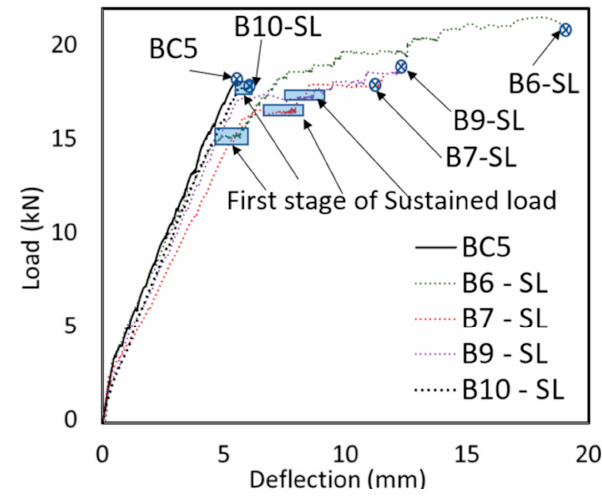
Figure 10. Load vs. deflection response of beam series II.